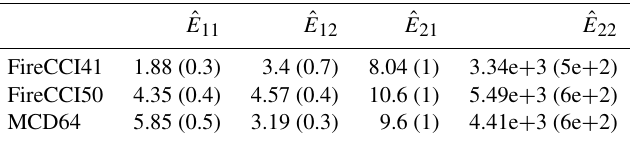
Table 2. Estimated error matrices for each product at the global level. Cells of the error matrices represents areas of 10 13 m 2 . ˆ E 11 is the BA according to both the product and the reference classifications, ˆ E 12 is the commission error area, ˆ E 21 is the omission error area and ˆ E 22 is the unburned area according to both the product and the reference